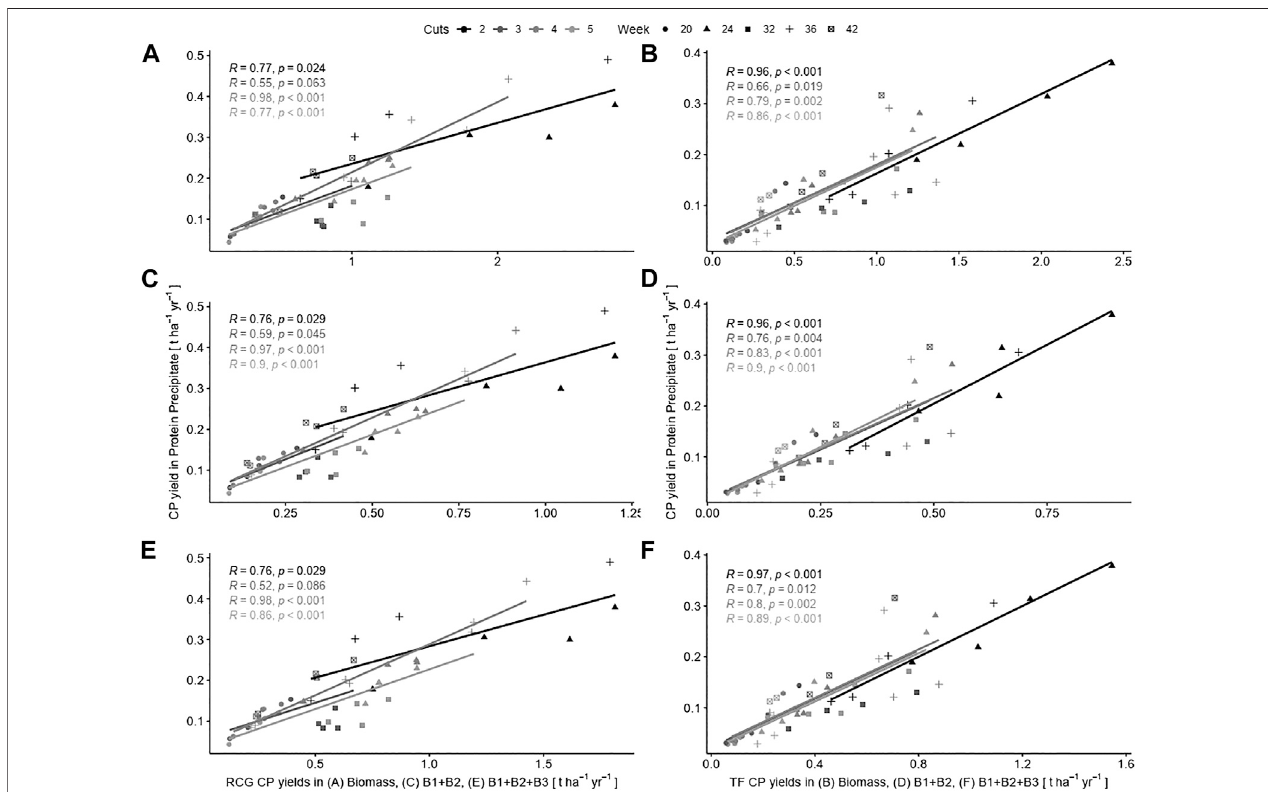
FIGURE 9 | Pearson correlations between crude protein (CP) yields in precipitated protein and crude protein in biomass (A, B) , neutral soluble Cornell Net Carbohydrate and ProteinSystem (CNCPS) fractions B1+B2 (C,D) , and acidsoluble CNCPS fractions B1+B2+ B3 (E, F) for thespecies reed canary grass(RCG; A , C , D ) and tall fescue (TF; B , D , F ). Treatments are indexed by differently shaded correlation lines, and harvest dates by symbols.